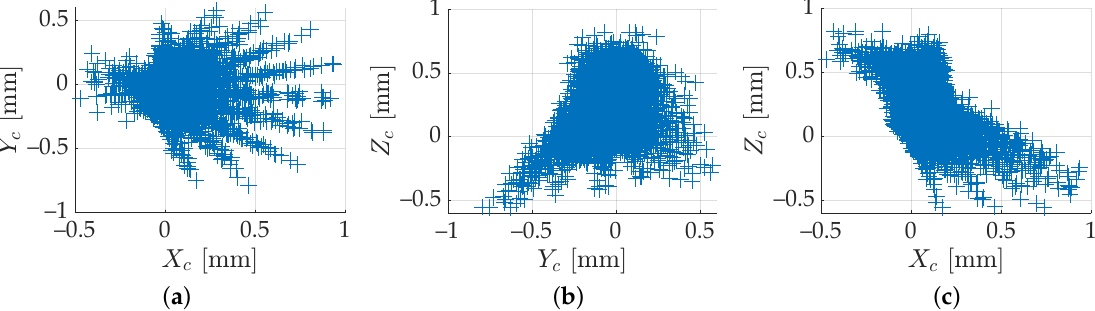
Figure 5. Same error cloud of Figure 4, plotted in the three Cartesian planes: ( a ) XY -plane; ( b ) YZ -plane; ( c ) ZX